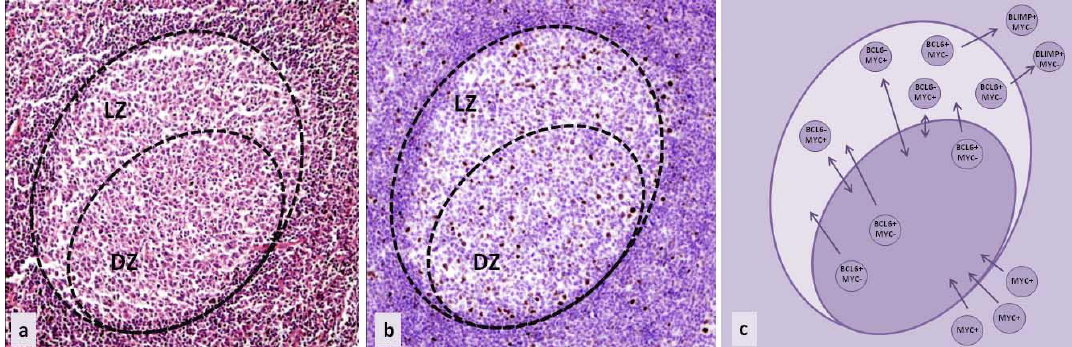
Figure 1. Germinal center of secondary follicle in secondary lymphatic tissue ( a ) haematoxylin and eosin stain (HE), 100×; ( b ) immunohistochemical staining of MYC expressing cells (brown), 100×; ( c ) simplified schematic representation of the regulation of MYC expression in B cell maturation. (DZ—dark zone of germinal center, LZ—light zone of germinal center.)